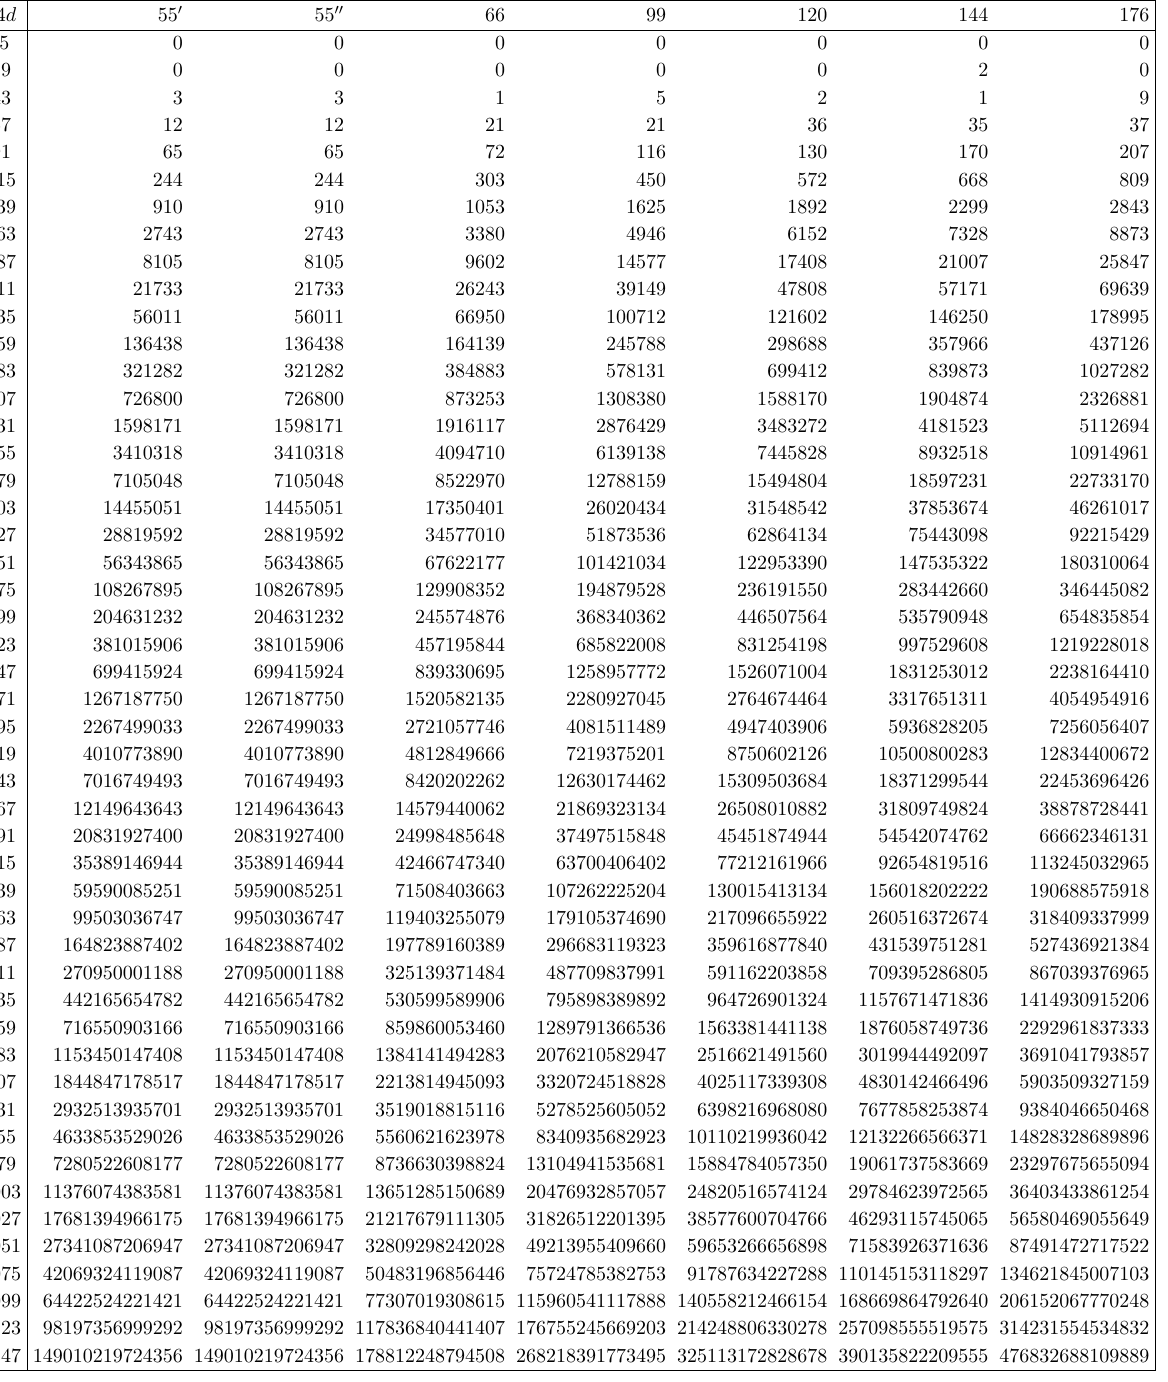
Table 5 . Multiplicity generating functions f (1)